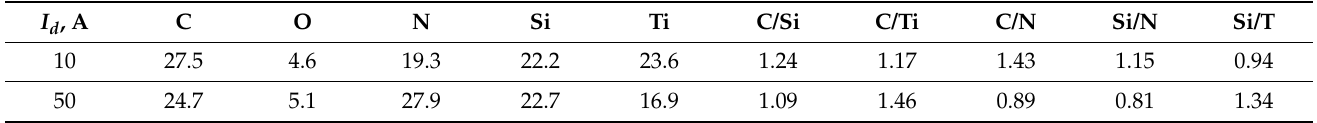
Table 1. The chemical composition of the surface of the samples (at.%) and the ratio of elements in the coatings.